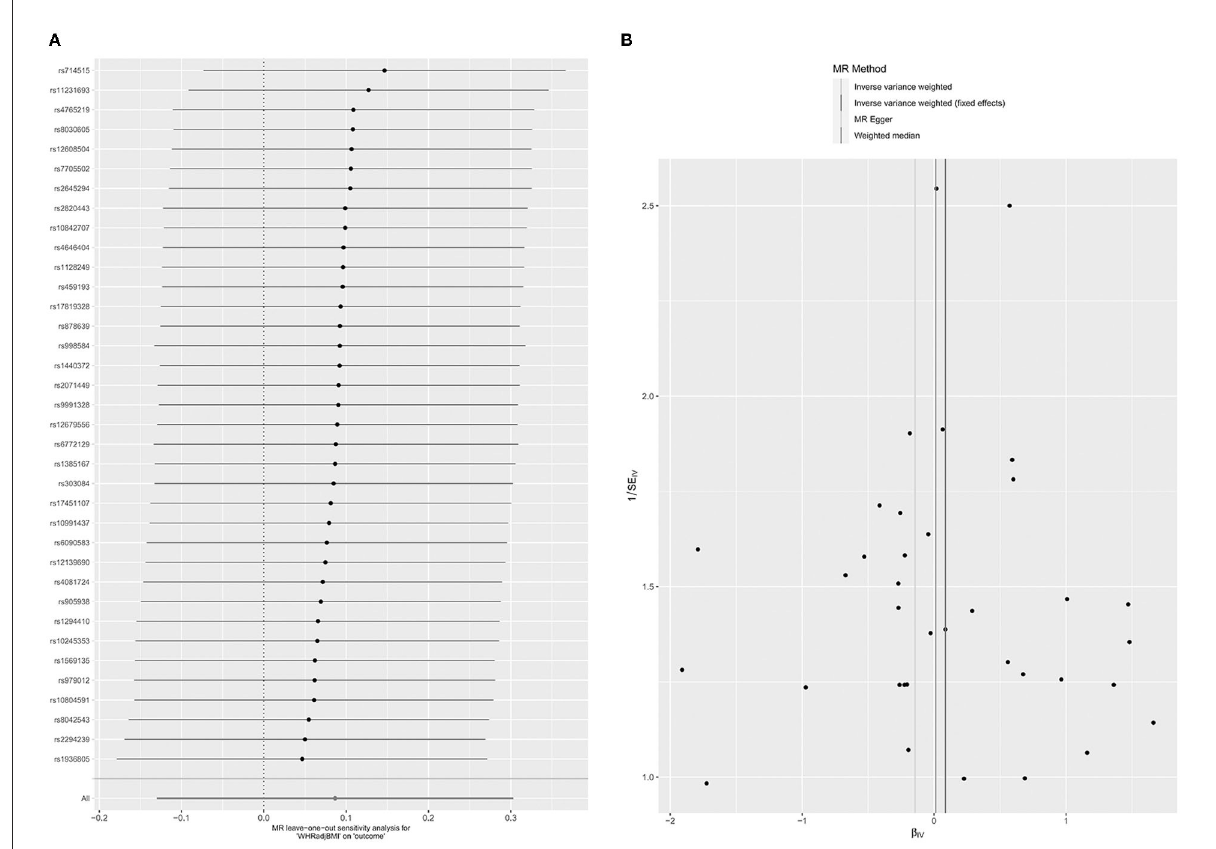
FIGURE3 Leave-one-out permutation analysis plot (A) and Funnel plot (B) of WHRadjBMI.